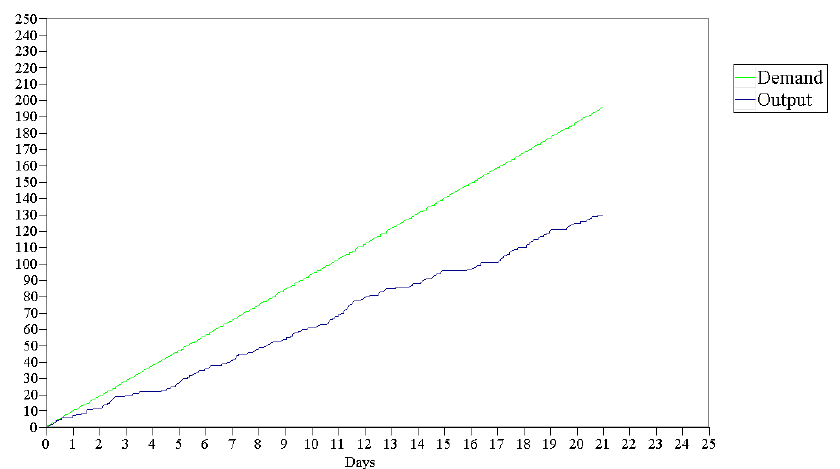
Figure 8. Graph of supply and demand obtained from the simulation model created for the current situation.